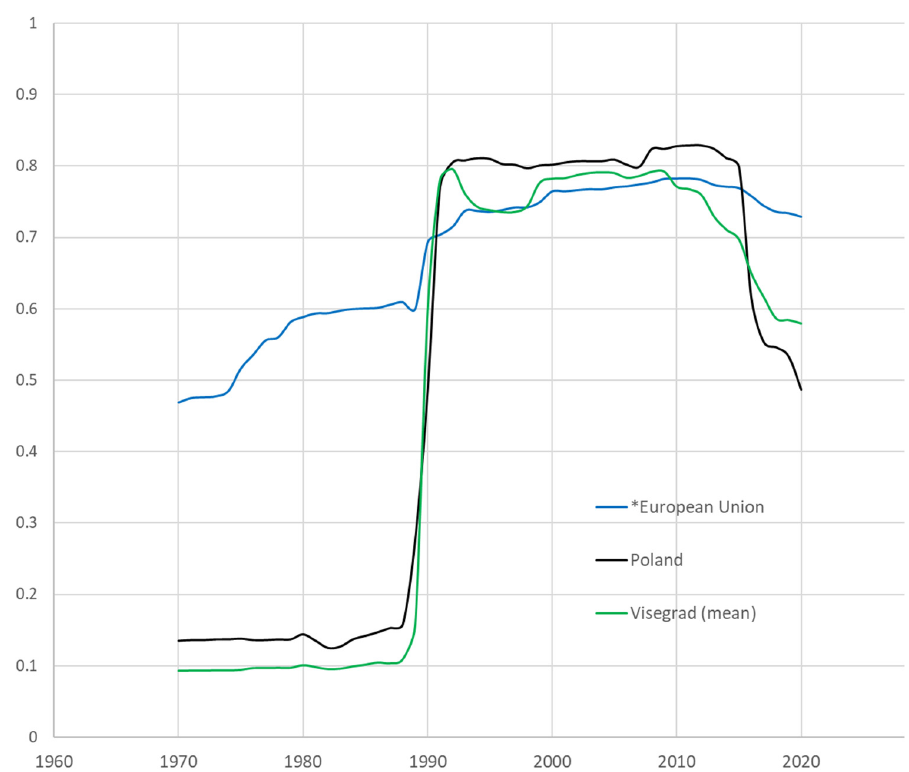
Figure 19. Liberal democracy index. Source: VDEM [51].